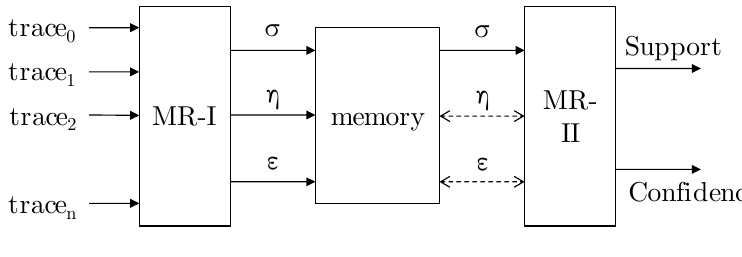
Figure 1. Infrastructure of the calculation